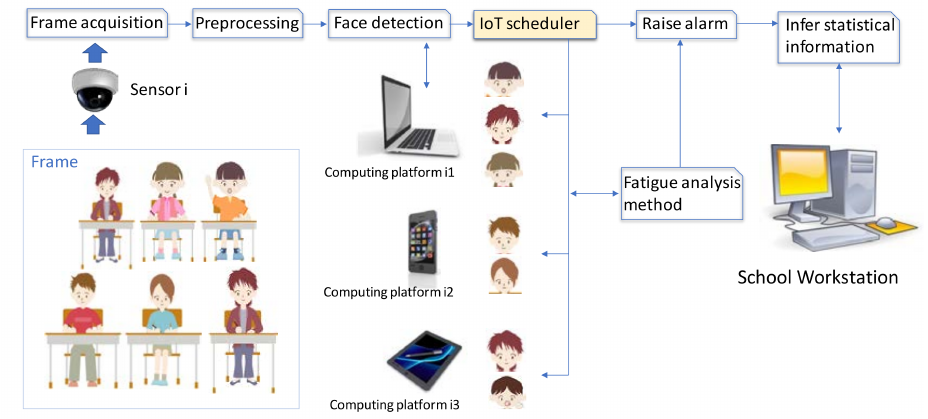
Figure 6. Collaborative work